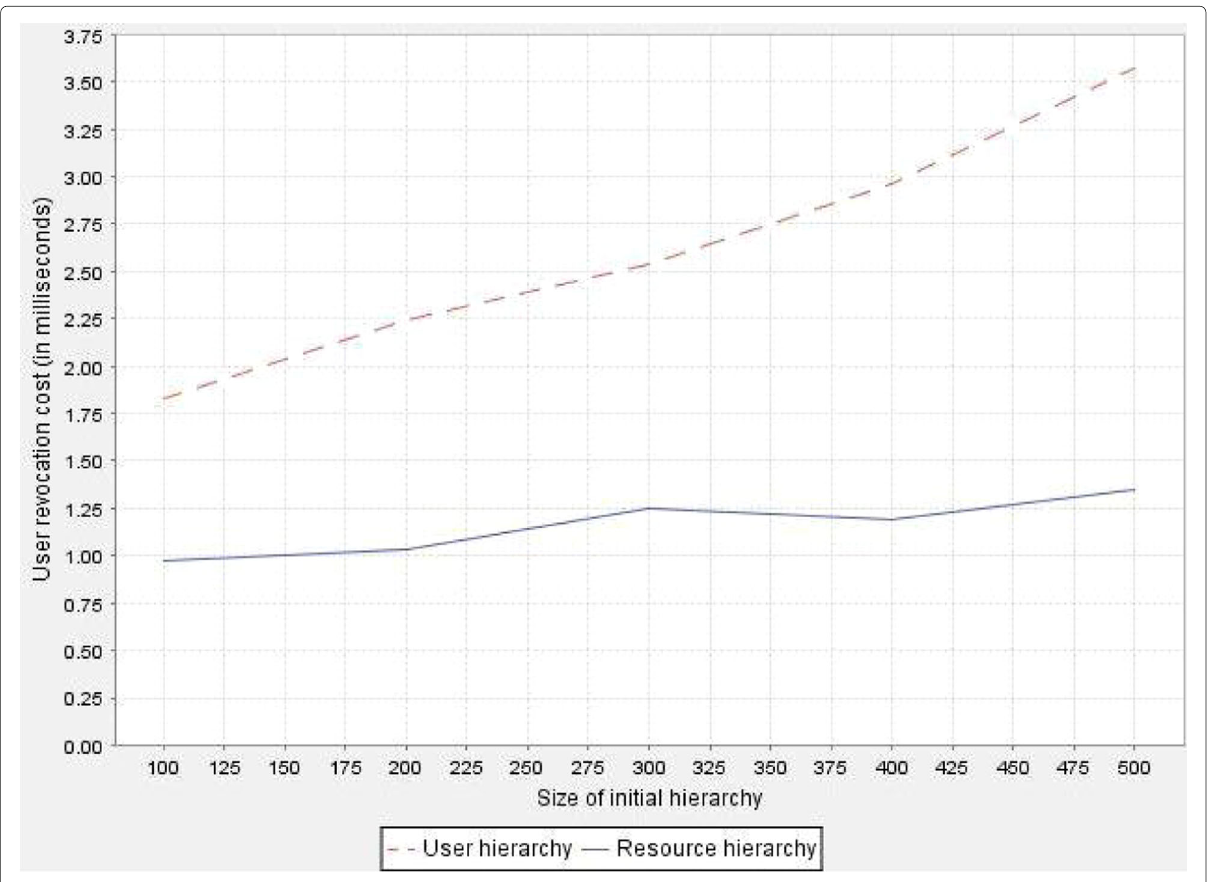
Fig. 17 Average elapsed time of one user revoke